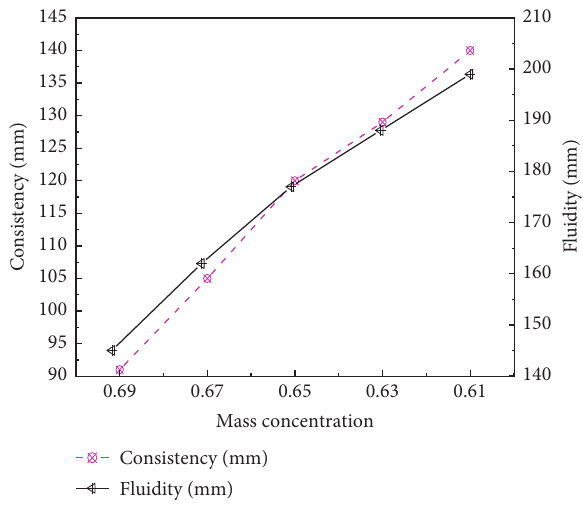
Figure 3: The consistency and fluidity of the waste sediment-based grouting material with different mass concentrations of solid